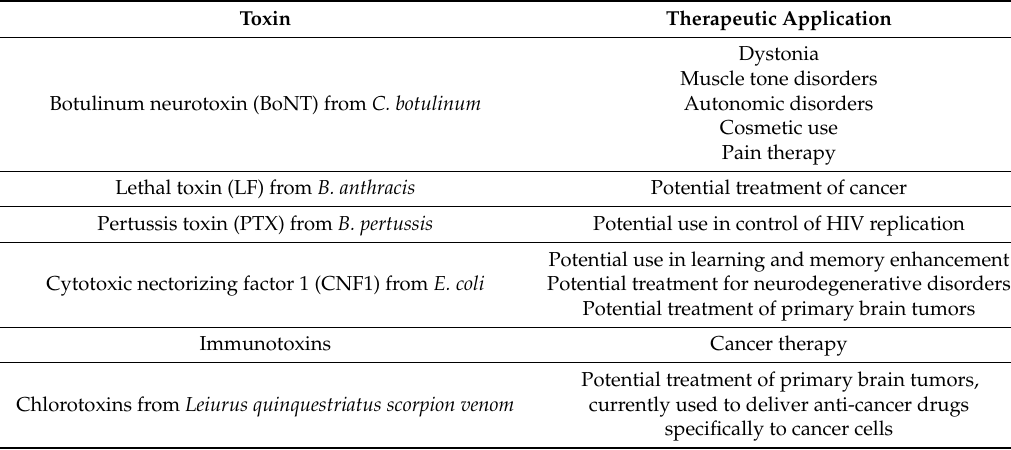
Table 1. Current and potential therapeutic applications of protein